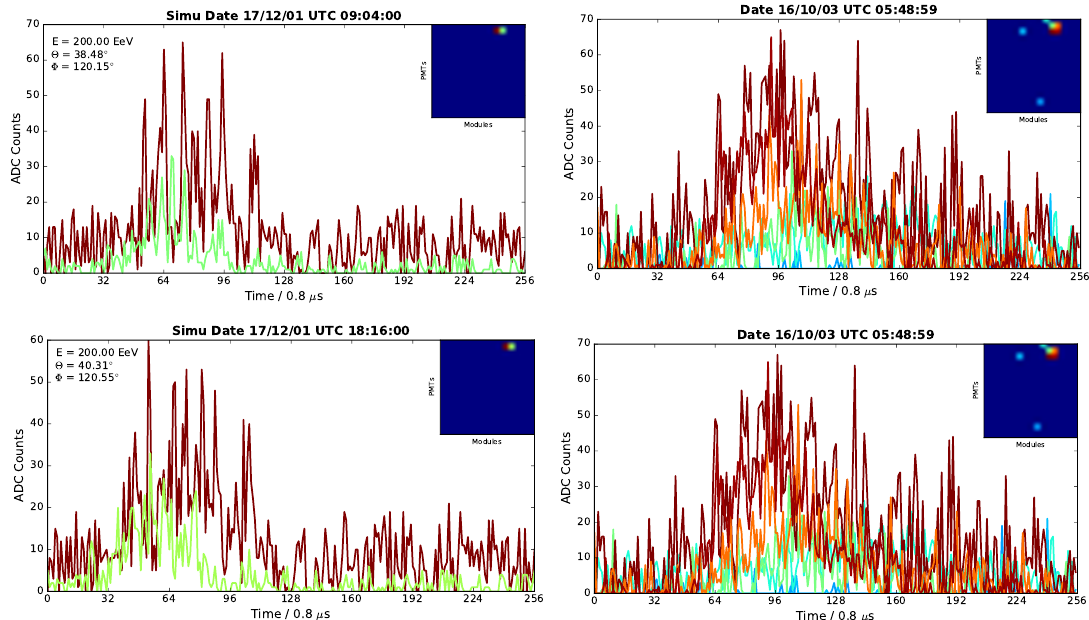
Figure 3. Simulations (left) of an experimental event (right) which has characteristics similar to an EECR event. An arbitrary response of the TUS detector is assumed to match signal intensity in simulations with those expected for a 200 EeV